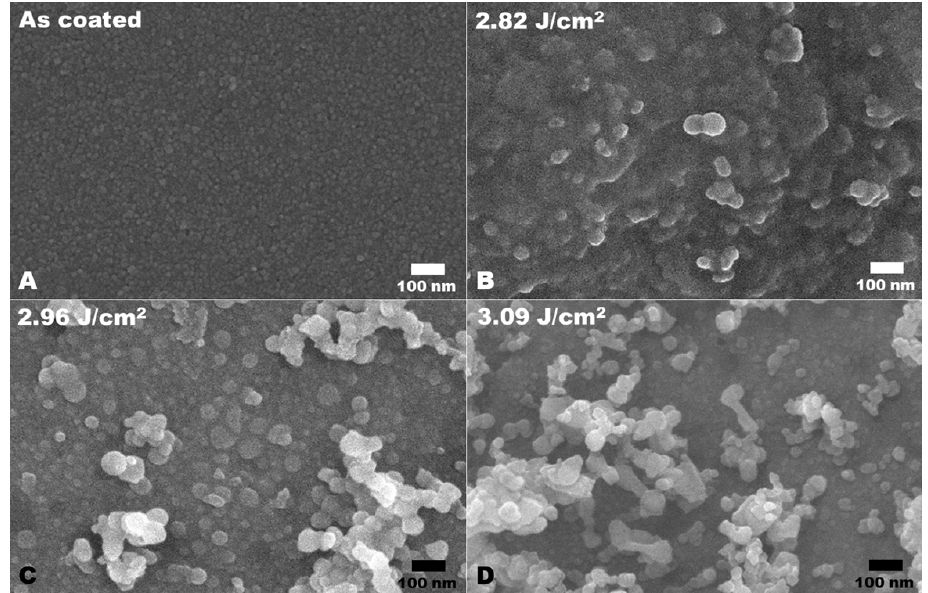
Figure 2. UV-vis-NIR absorption spectra of the as-coated CZTS thin film and corresponding ( α h ν ) 2 vs. h ν curve.